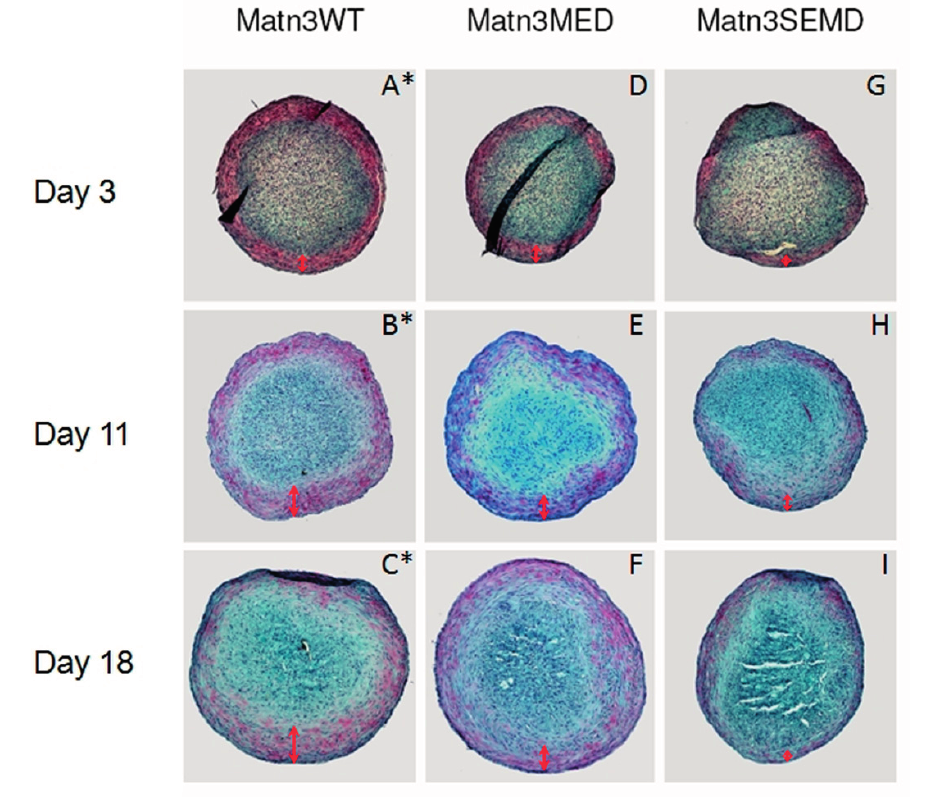
Figure 8. The SEMD MATN3 mutation hinders MATN3 induced chondrogenesis of primary porcine synovium derived stem cells. ( A – C ) Extent of chondrogenesis of WT MATN3 transfected; ( D – F ) MED MATN3 transfected and ( G – I ) SEMD MATN3 transfected porcine SDMSC pellets as indicated by Safranin-O staining. Red double headed arrows indicate the depth of each pellet’s peripheral cartilaginous zone that stained positive with Safranin-O. * Note: A , B and C were reference panels from a previous study [26] for the purpose of comparing the extent of chondrogenesis in WT MATN3 transfected cells vs. MED or SEMD MATN3 transfected